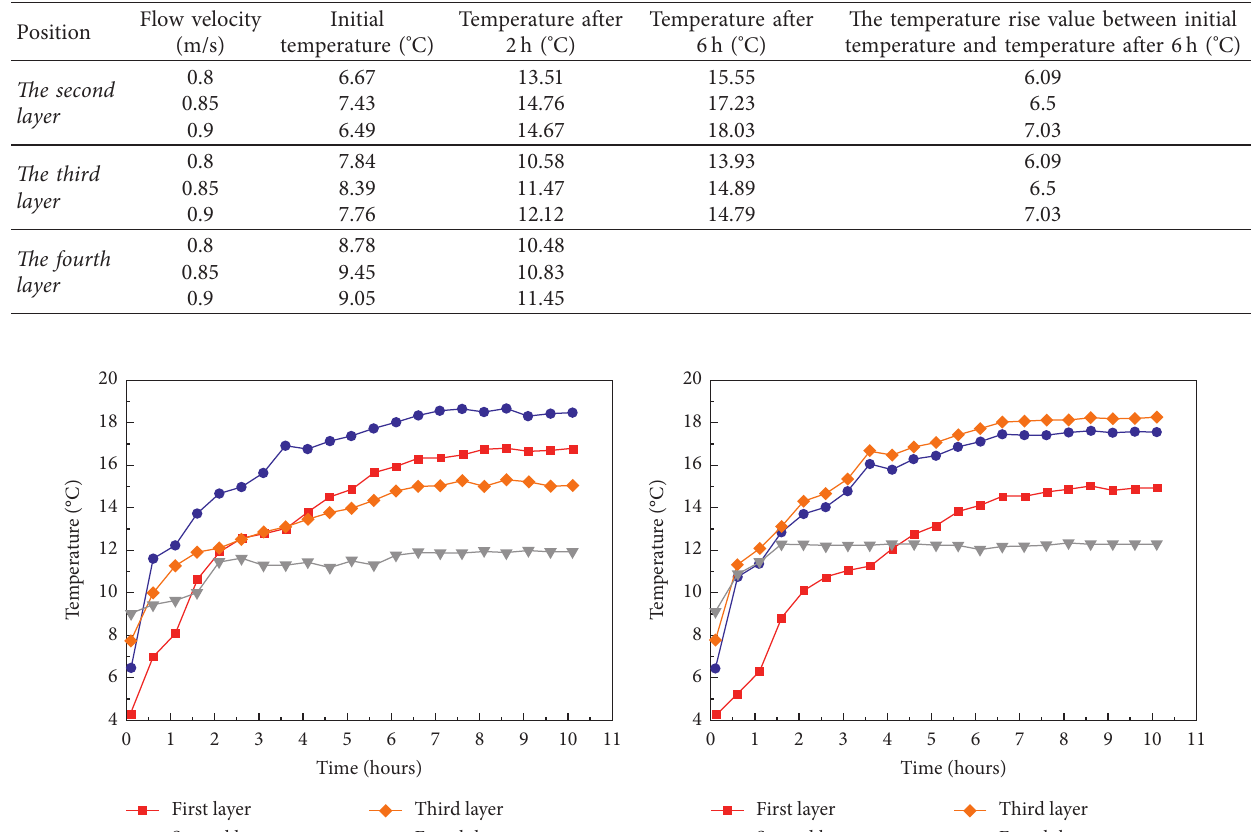
Table 6: Temperature rise value of the second, third, and fourth layers under three flow